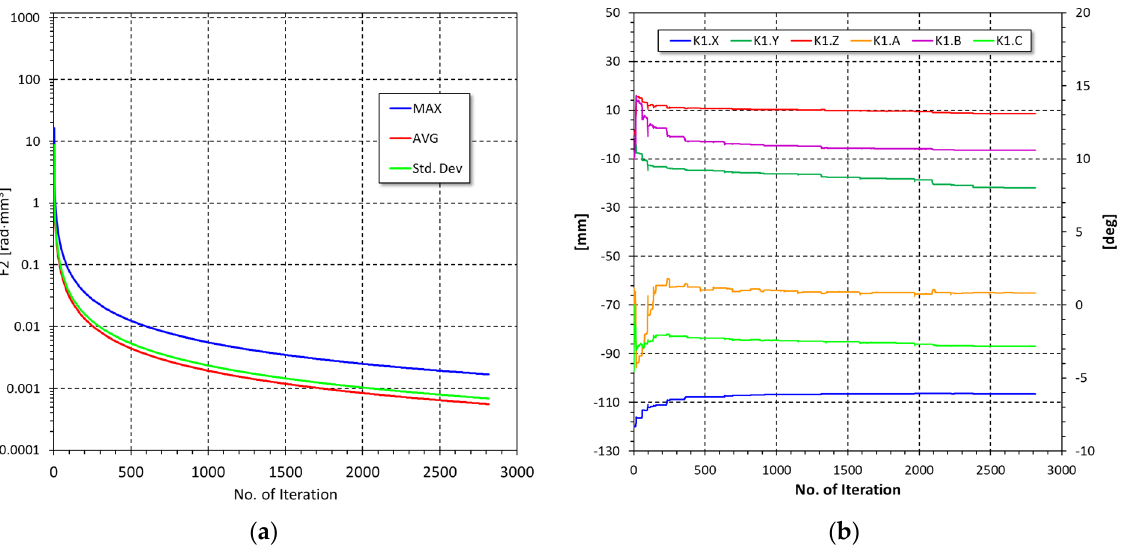
Figure 13. ( a ) Course of minimization of the objective function F 2 and ( b ) the values of the sought parameters worked out in subsequent iterations.